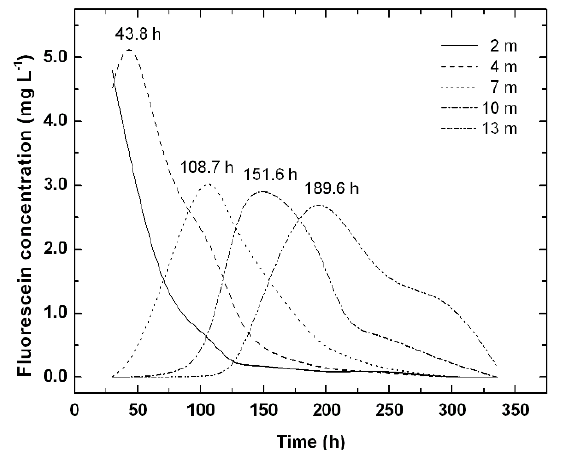
Figure 2. Fluorescein flow movement in the constructed wetland bed.